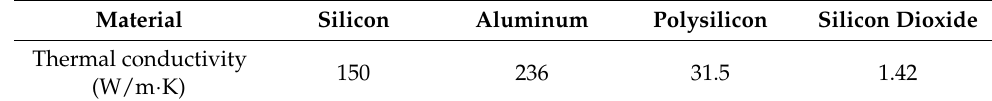
Table 2. Thermal conductivity of materials.